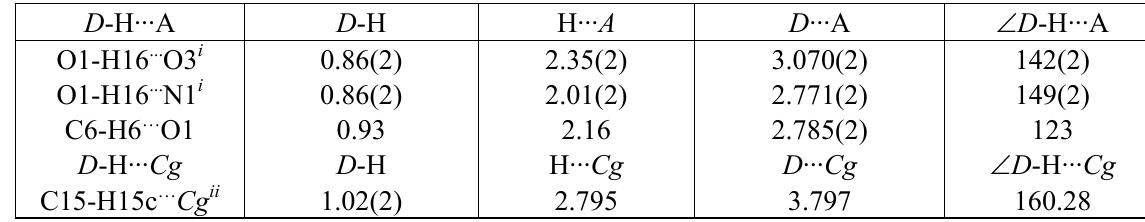
Table 3. Geometric parameters for H-bonds in ( 1 ),